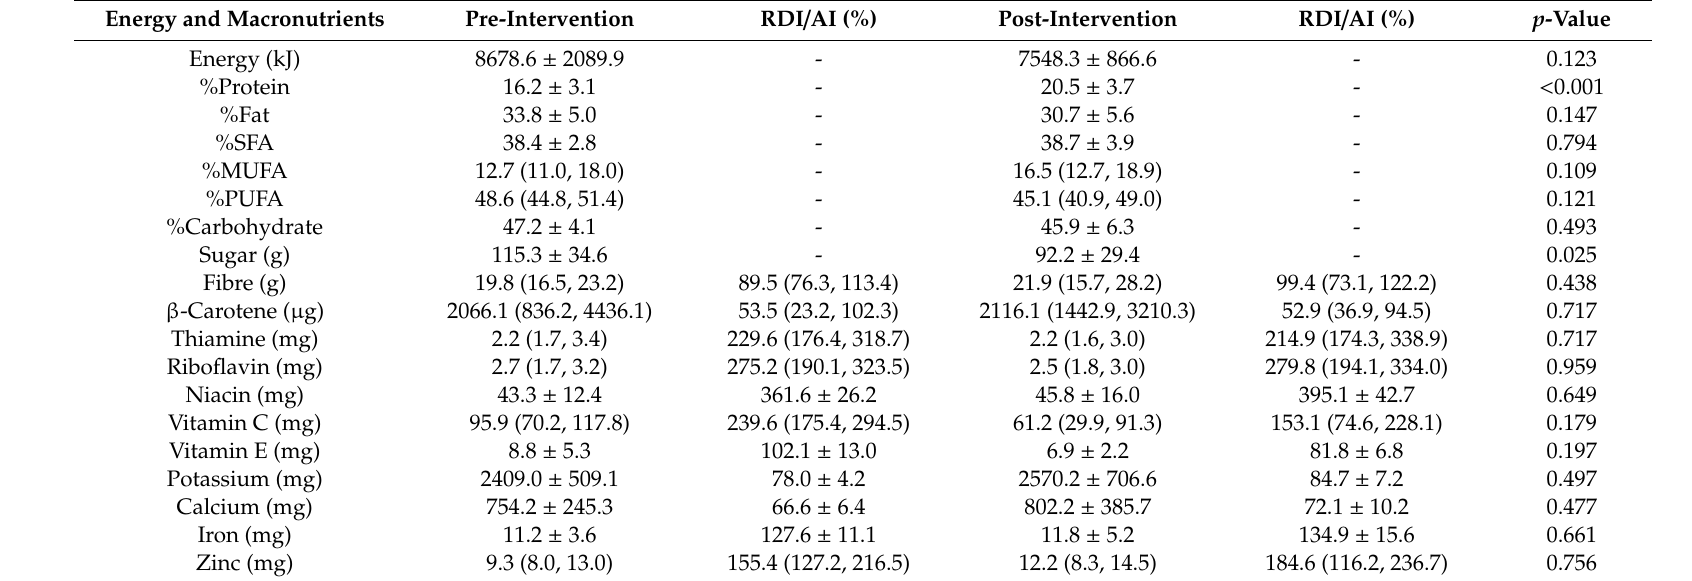
Table 3. Change in dietary intakes in obese asthmatic children following a 10-week dietary intervention. Energy and